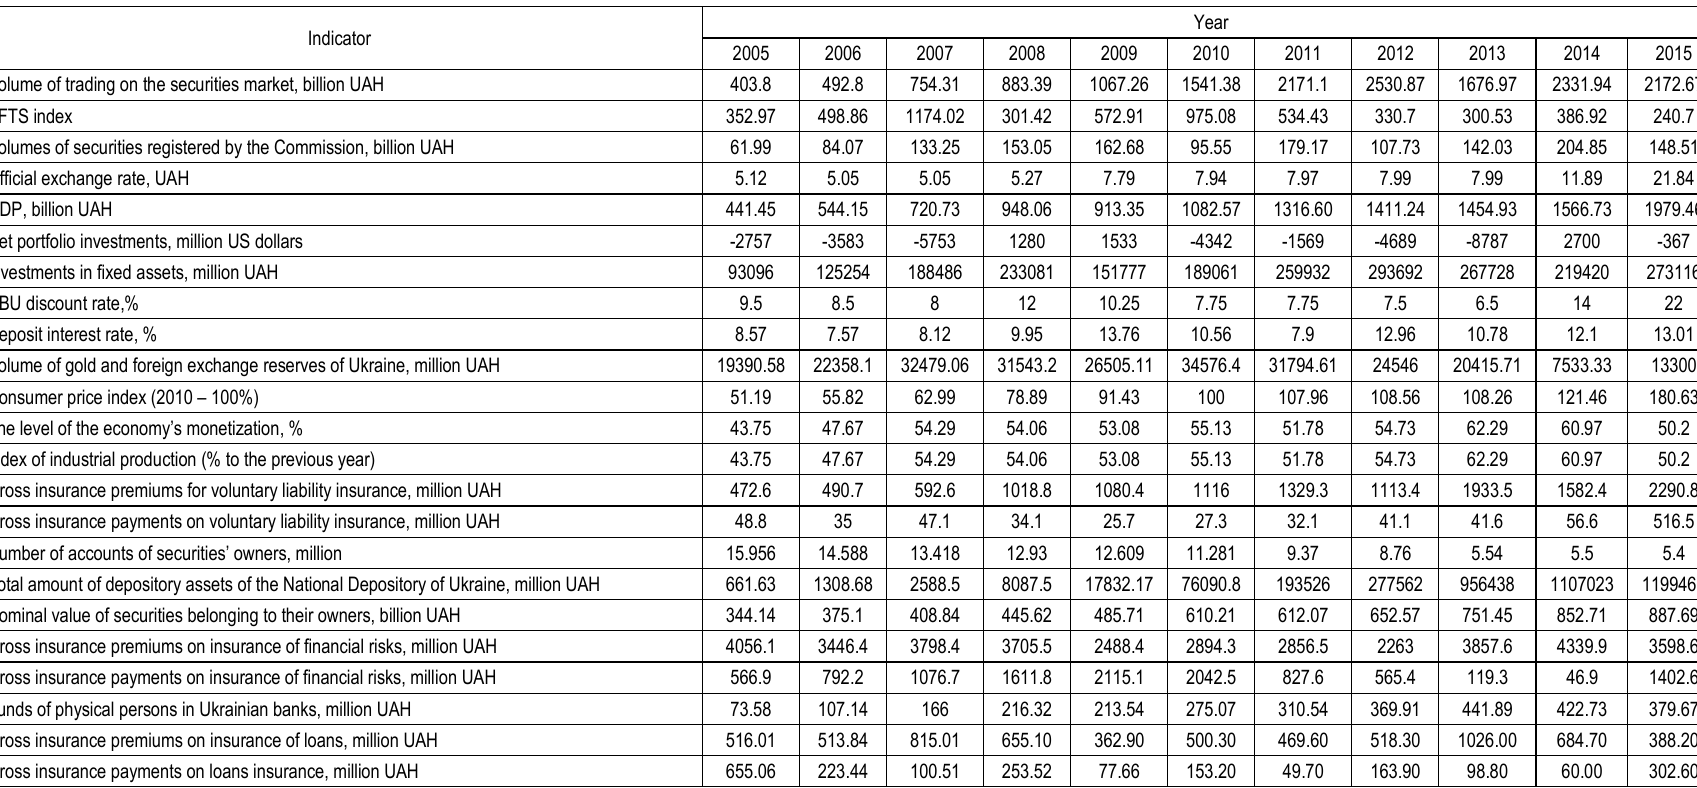
Table A.1. Information provision for the research of capacity of the sectors of insurance of depositories’ professional risks and insura nce of individual investments of physical persons – participants of the stock